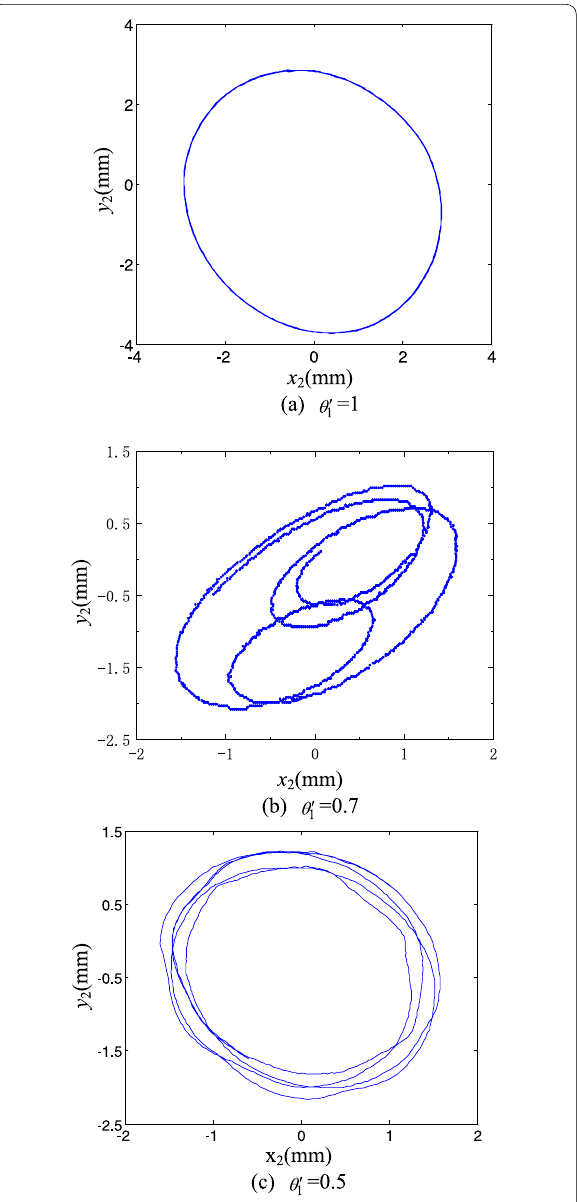
Figure 19 Trajectory of the disc under the different θ ′